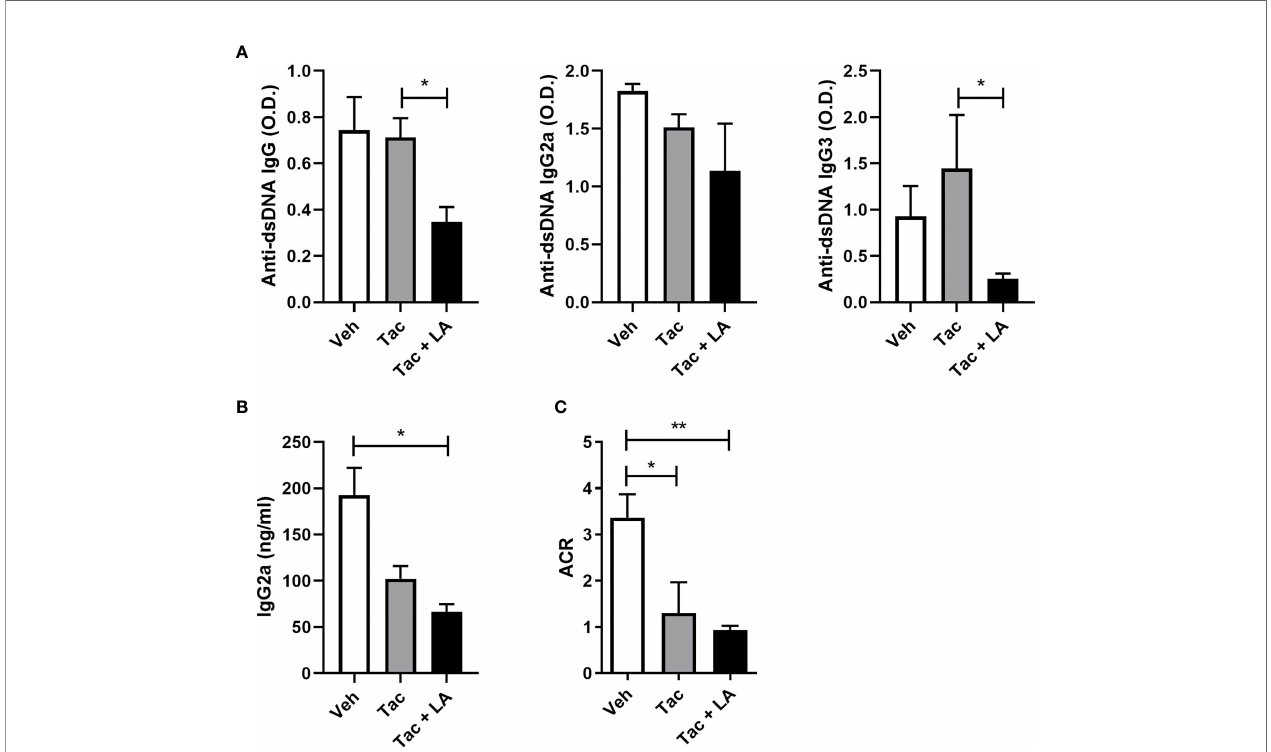
FIGURE 3 | The combination of Tac and LA inhibits the production of autoantibodies in lupus-prone mice. After the in vivo experiments, as described in Figure 2 , serum and urine samples were acquired from 16-week-old MRL/ lpr mice (n = 5). (A) Levels of anti-dsDNA antibodies (total IgG) and their isotypes (IgG2a and IgG3) in the sera of lupus-prone mice treated with vehicle or Tac ± LA. (B) Levels of IgG2a in the sera from MRL/ lpr mice. (C) Albumin/creatinine ratio (ACR) measured from urine samples of MRL/ lpr mice at the age of 16 weeks. All experiments were performed at least three times in triplicate. Data are shown as mean ± SEM. * p < 0.05, ** p <